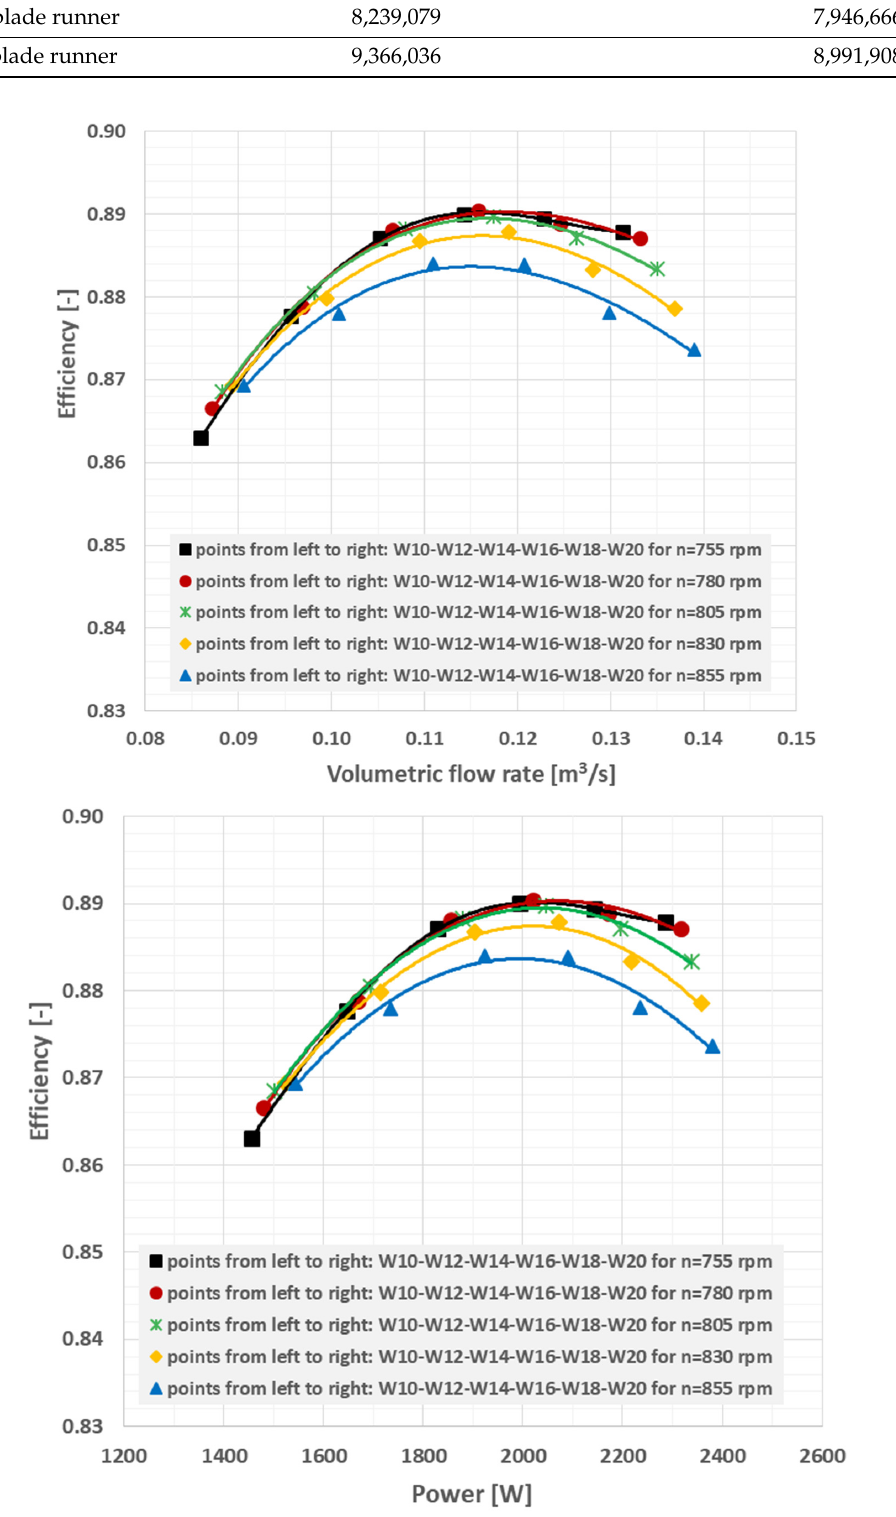
Figure 8. Efficiency curves vs. flow rate and power for semi-Kaplan turbine with 4-blade runner.